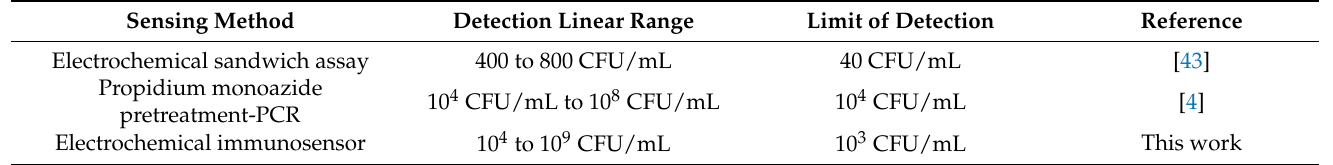
Figure 6. ( A ) CVs of immunosensor towards 10 1 , 10 2 , 10 3 , 10 4 , 10 5 , 10 6 , 10 7 , 10 8 , 10 9 and 10 10 CFU/mL of L. brevis (an arrow indicates the direction of the increasing L. brevis concentration, from 10 1 to 10 10 CFU/mL). ( B ) Plots and linear fitting line of ∆ current against the concentrates of L. brevis. Table 1. Comparison of sensing performance towards L. brevis .